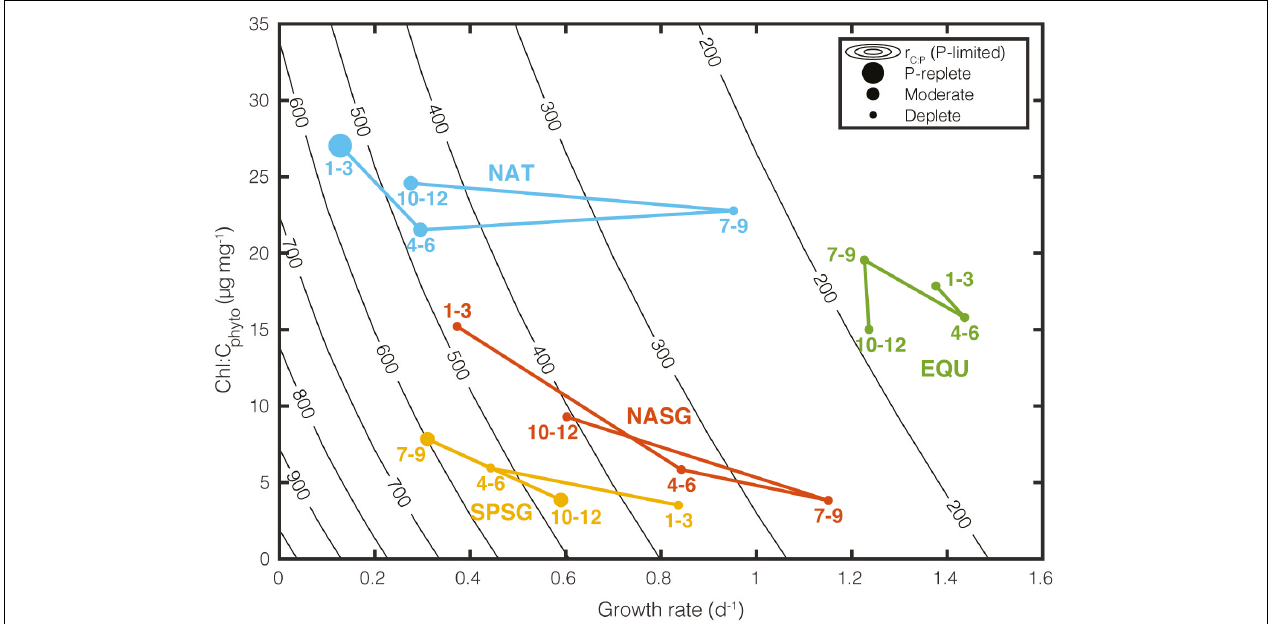
FIGURE 4 | Influence of growth rate ( µ ) and Chl:C phyto on r C : P under P limitation. Colored points represent seasonally averaged CAFE-informed Chl:C phyto , µ , and r C : P for four oceanographic regions (NAT, North Atlantic Temperate; NASG, North Atlantic Subtropical Gyre; SPSG, South Pacific Subtropical Gyre; EQU, Equatorial Upwelling region. The marker size represents the degree of P limitation within the region (P-replete: < 20% of the region is P-limited, Moderate: 20–80%, Deplete: > 80%). The numbers next to the markers correspond to the months of the year. Contour lines show C:P calculated under varying µ and Chl:C phyto with phytoplankton stoichiometry model under P-limited